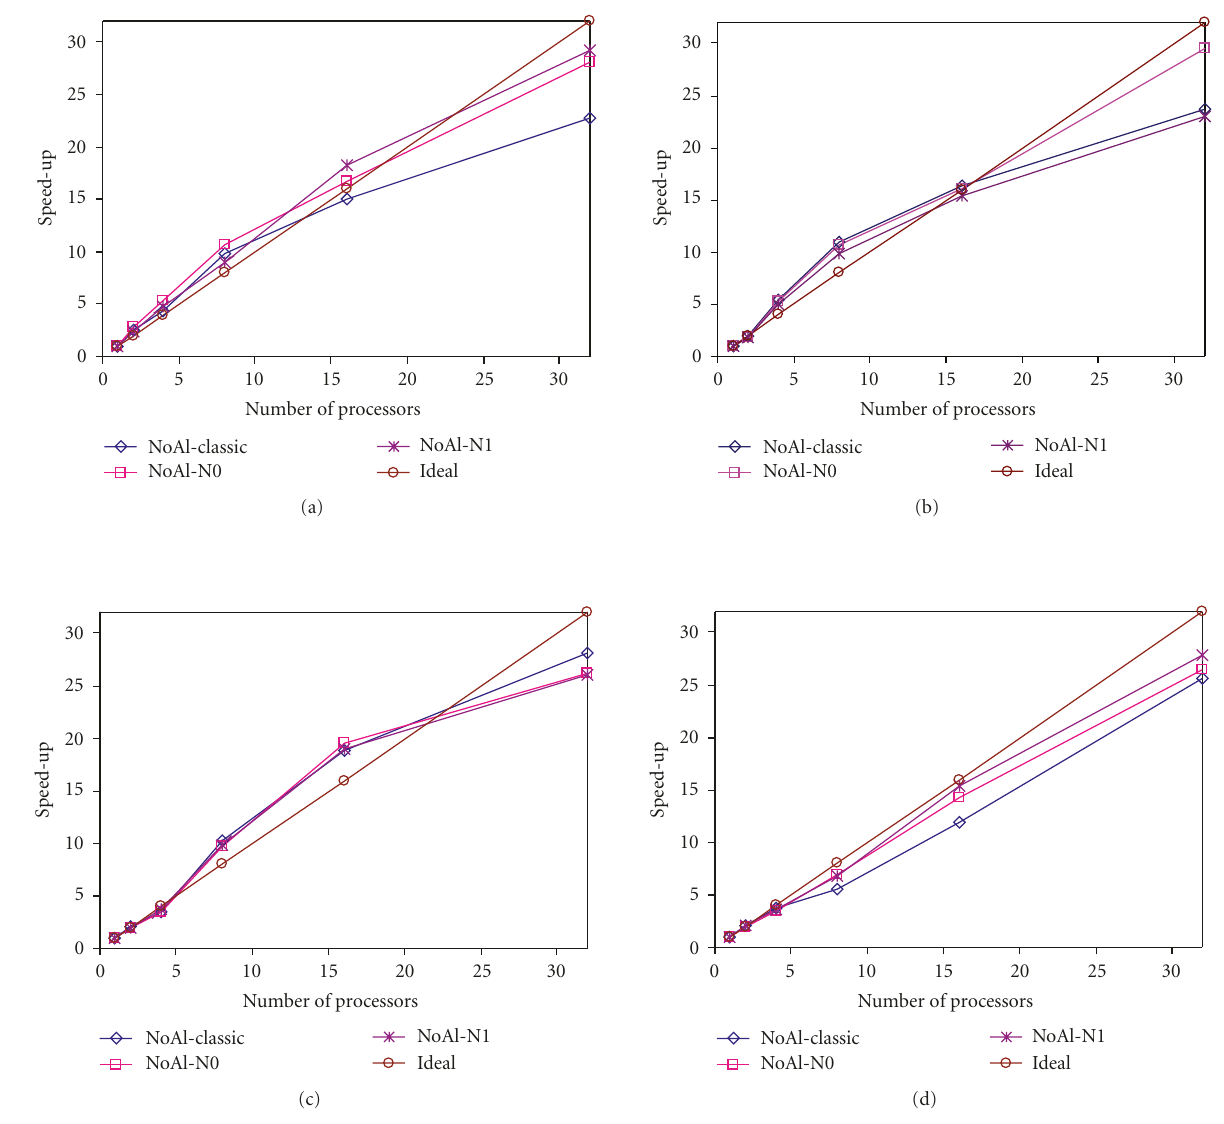
Figure 10: Speed-up: frames of 1024 × 1024 pixels (a) 4 frames/GOF, (b) 8 frames/GOF, (c) 16 frames/GOF, (d) 32 frames/GOF.